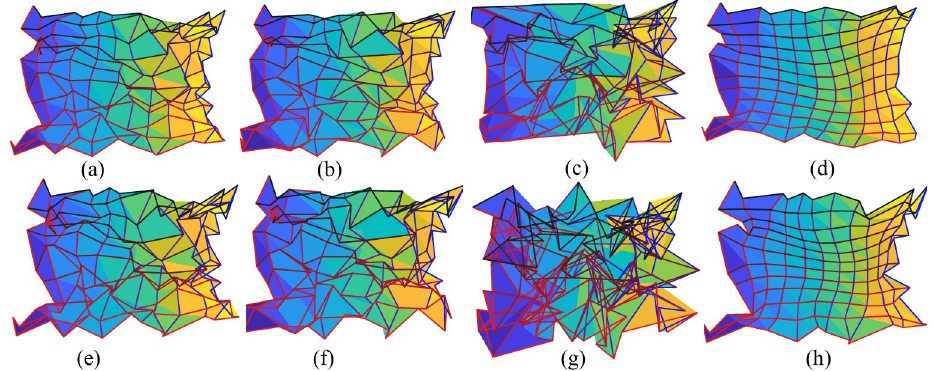
Fig 8. Smoothing results for the synthetic data: (A)-(D) are the results with PSNR = 10 for (A) Average smoothing, (B) Median smoothing, (C) Laplacian smoothing, and (D) proposed topological smoothing; (E)-(H) are the results with the same order as (A)-(D) but with PSNR = 5.